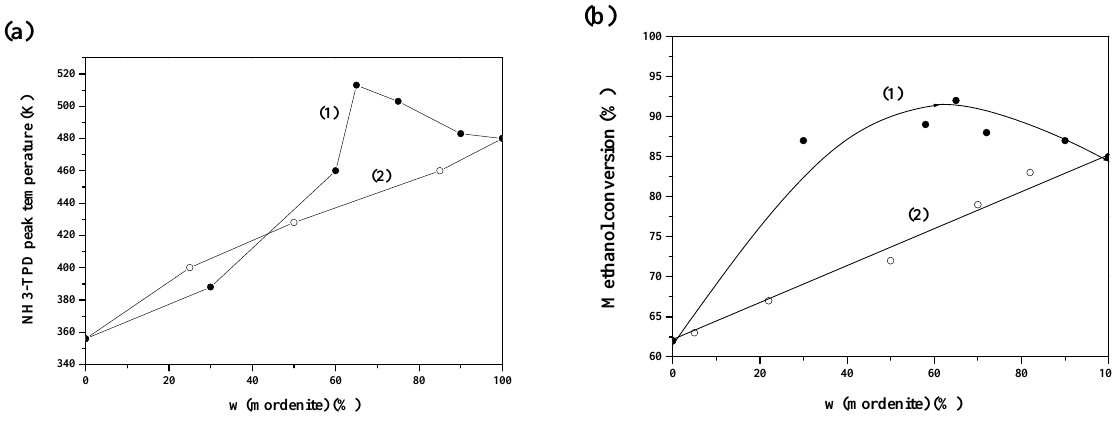
Figure 4. (a) Influence of mordenite phase content on the higher NH temperature; (b) Influence of mordenite phase content on catalytic performance of BEA/MOR and mechanical mixture of zeolite beta and mordenite for methanol dehydration (1)- BEA/MOR, (2)-mechanical mixture. Adapted from Reference [133].